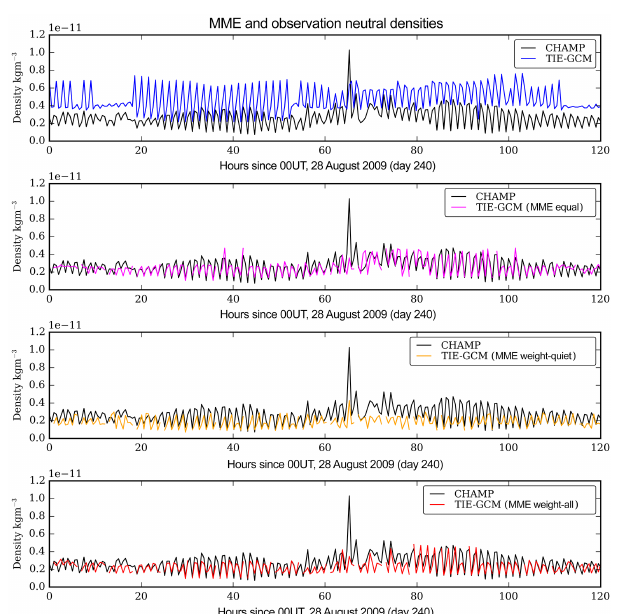
Figure 16. Top panel shows the neutral density from the CHAMP observations and the original TIE-GCM run. The subsequent pan- els then show the CHAMP observations with each of the new TIE- GCM outputs using the MMEs as the initial conditions every 6h.